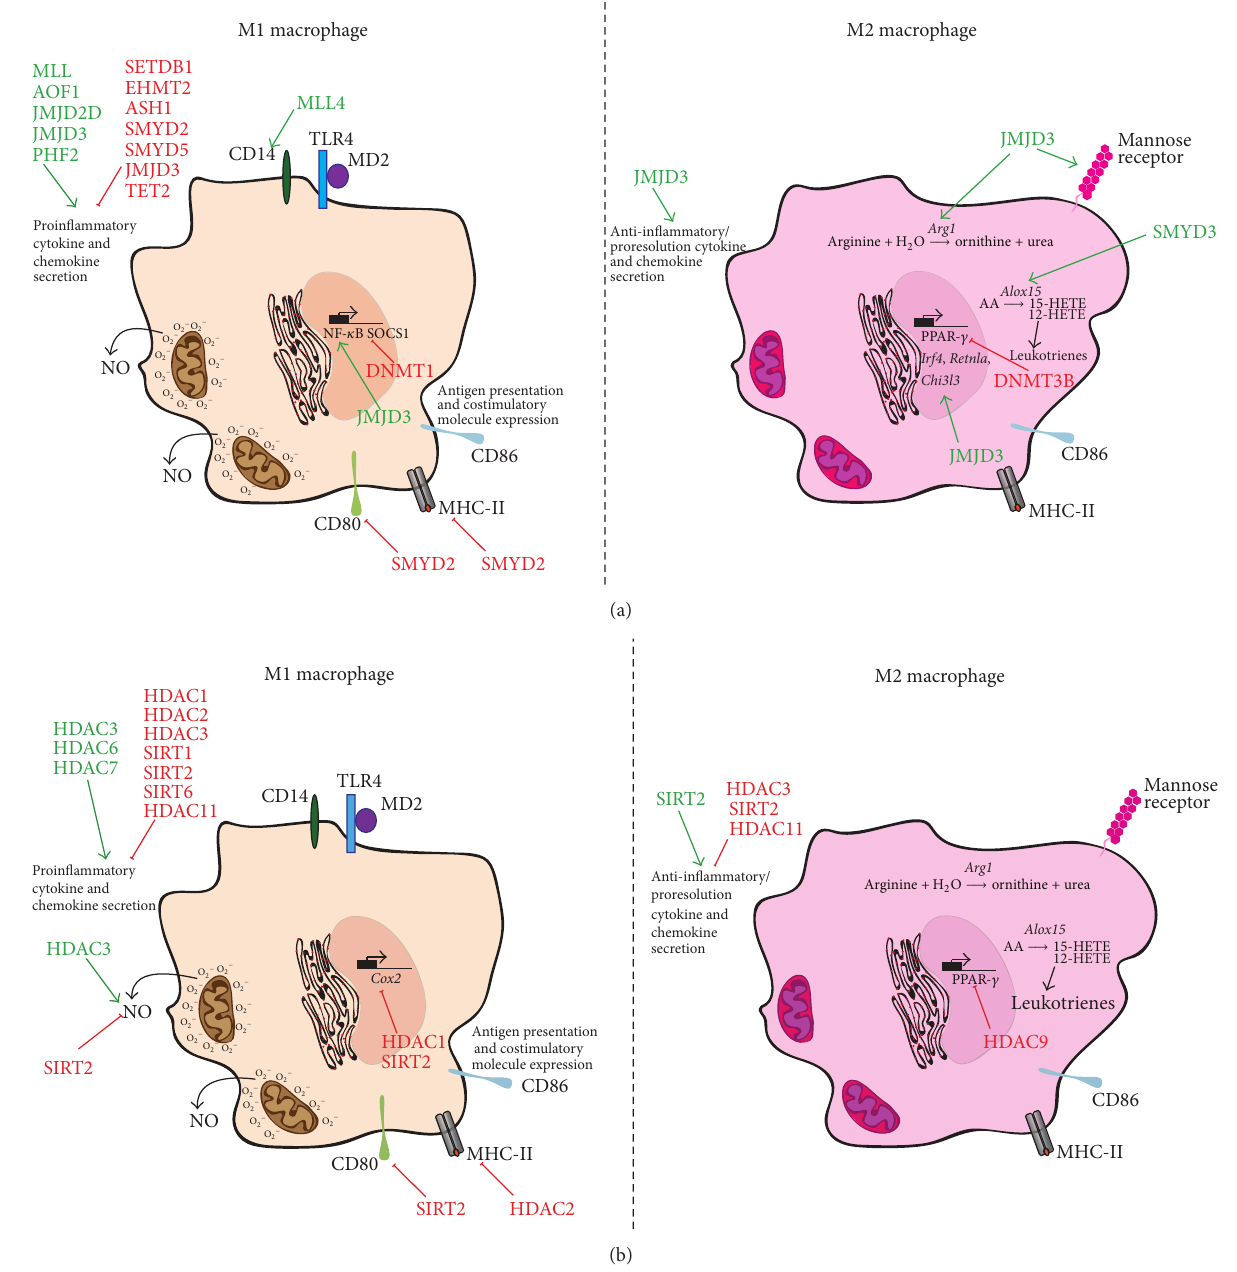
Figure 2: Histone methylation and acetylation status affect gene expression and macrophage polarisation to the M1 or the M2 phenotype. (a) HMTsinducethesecretionofproinflammatorycytokinesandchemokinesinthecellmicroenvironmentandstabilisethelevelsofCD14onthe macrophage surface. In contrast, some HMTs suppress the expression of MHC-II and costimulatory molecules and modulate the secretion of proinflammatory mediators. These enzymes contribute significantly to the M2 state, inducing the expression of M2 signature markers and the secretion of anti-inflammatory cytokines. (b) Although histone acetylation by HATs is generically associated with gene expression initiation, HDACs can skew the phenotype of macrophages equally to the M1 or the M2 phenotype. Depending on the HDACs subfamily, these enzymes have been shown to affect proinflammatory/proresolution cytokine secretion, MHC-II and costimulatory molecule expression, secretion of ROS and NO, and control of polarisation-determining TF, arachidonic acid (AA), and 12-hydroxyeicosatetraenoic acid